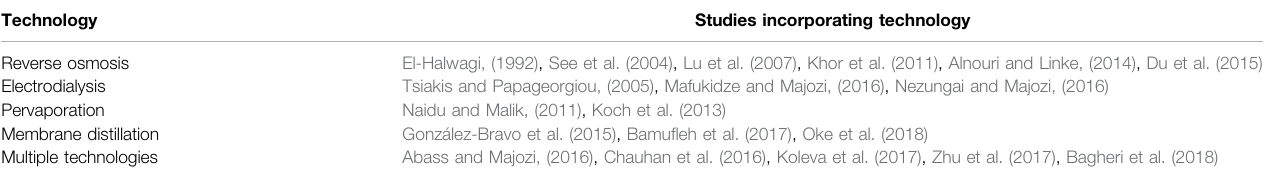
TABLE 1 | Studies incorporating the optimal design of regeneration technologies for water treatment. Technology Studies incorporating technology Reverse